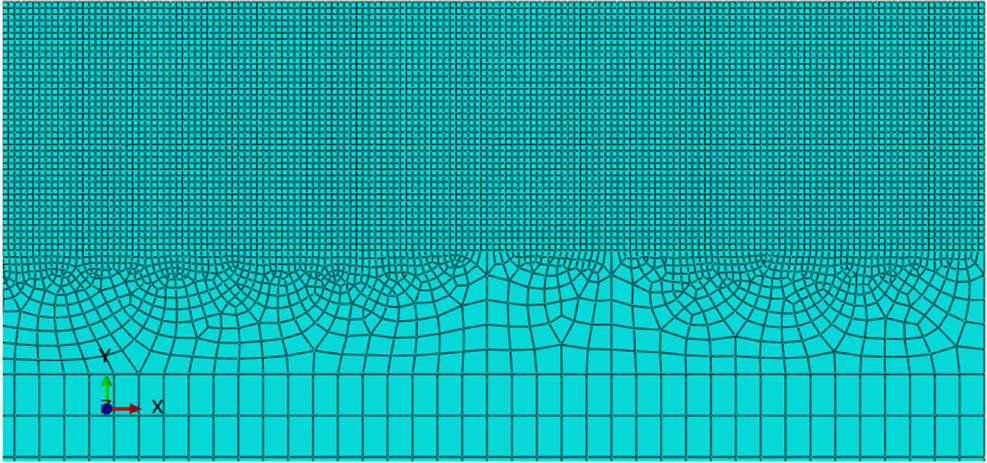
Figure 6. Meshing detail of the workpiece in Abaqus. The configuration script is available in the Supplementary